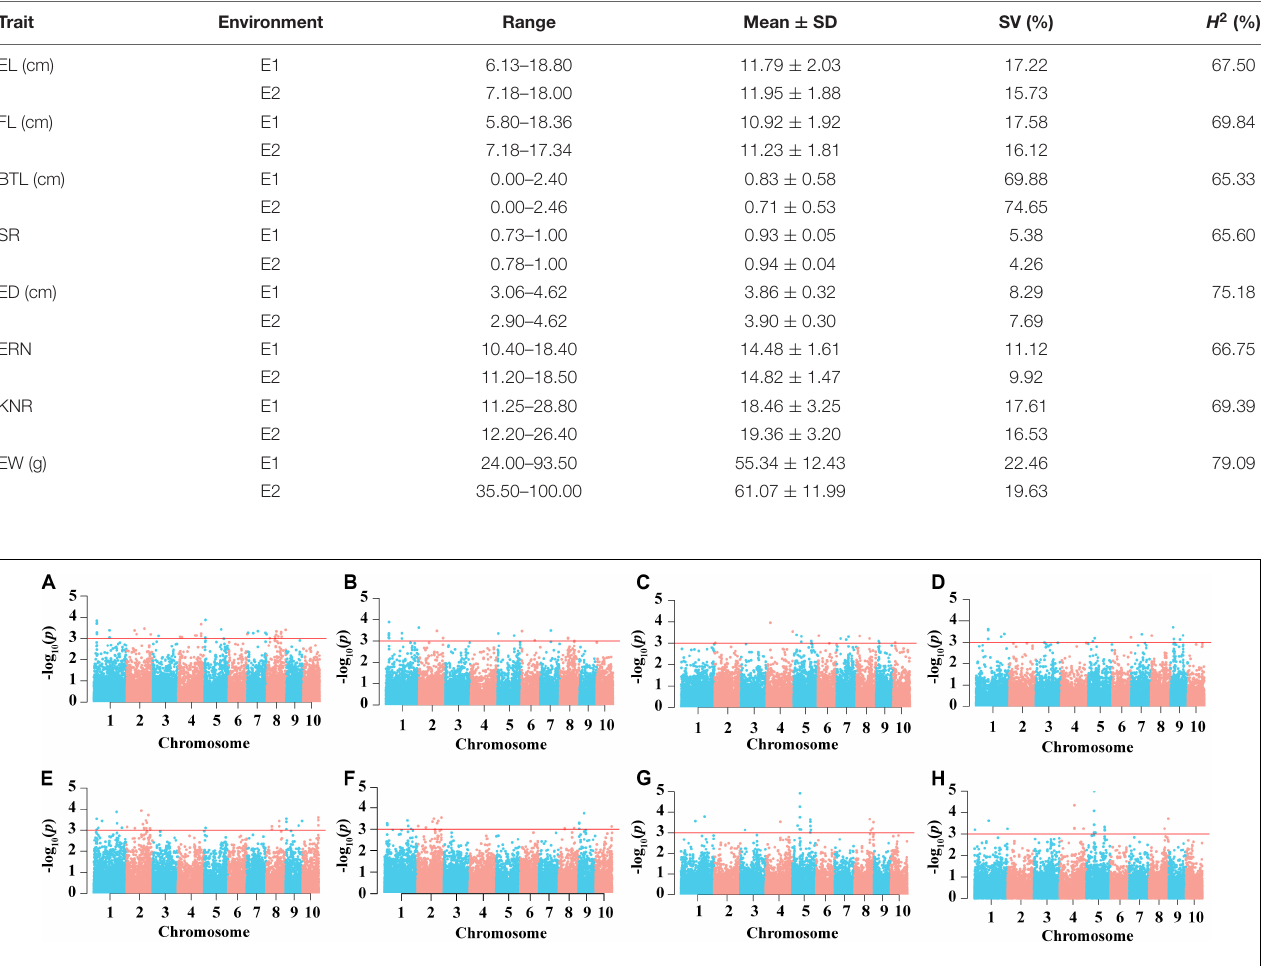
TABLE 1 | The basic statistics of ear length (EL), fruit length (FL), barren tip length (BTL) and setting rate (SR), ear weight (EW), ear diameter (ED), ear row number (ERN), and kernel number per row (KNR) of AM121 in two environments.